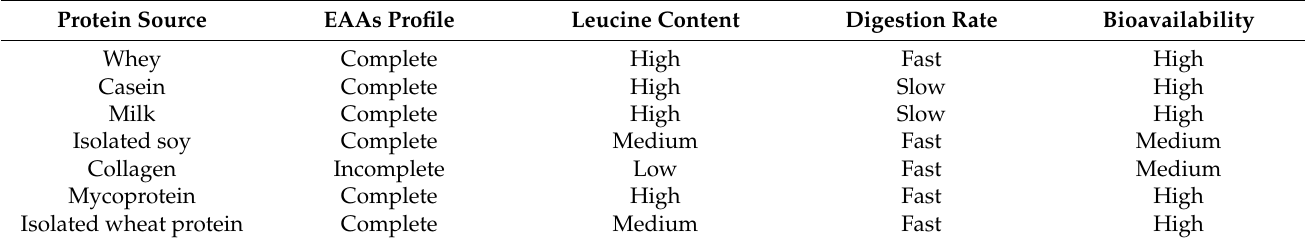
Table 1. Characteristics of different commercially available protein